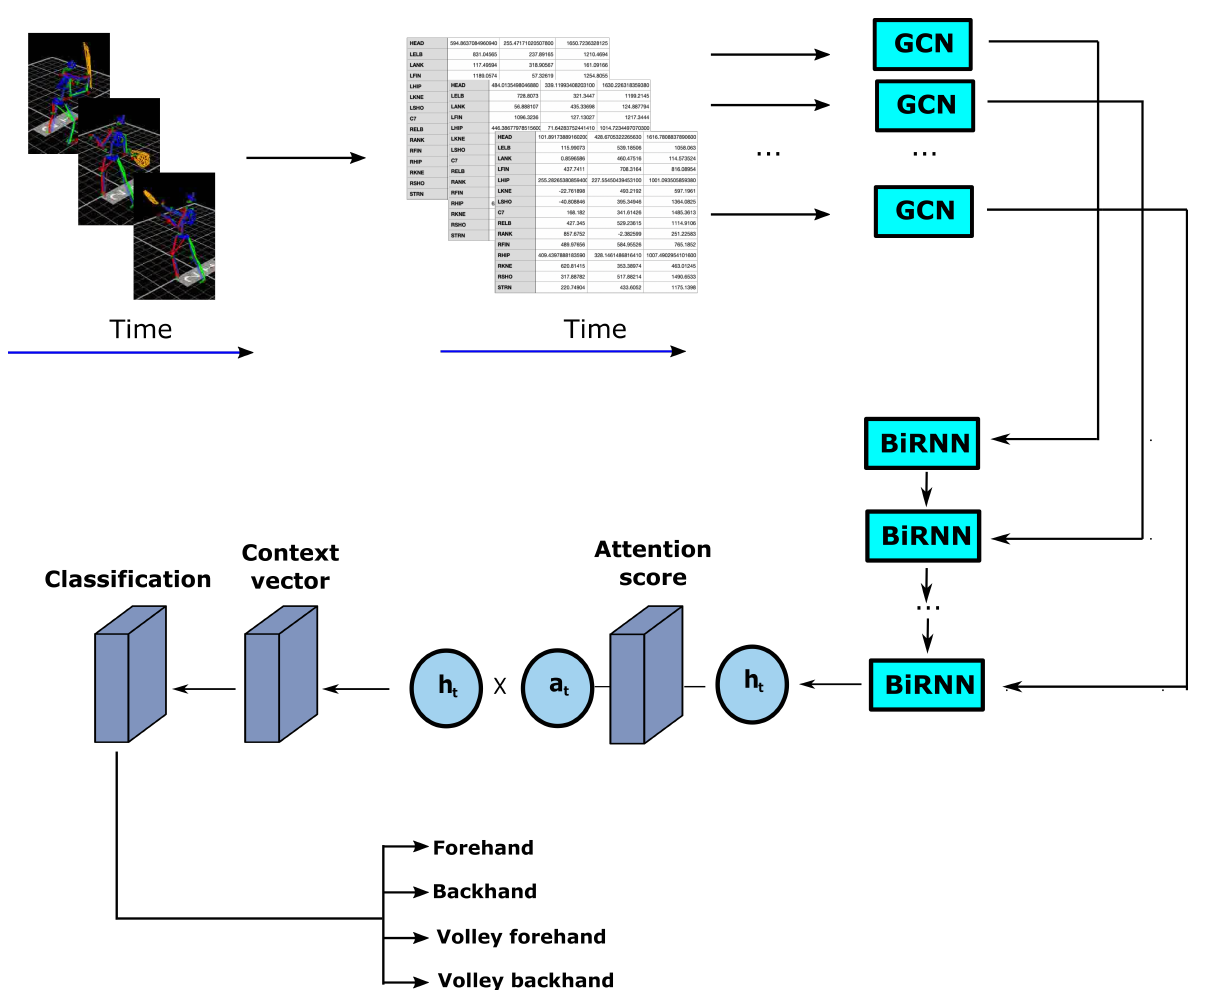
Figure 4. Classification model for tennis data